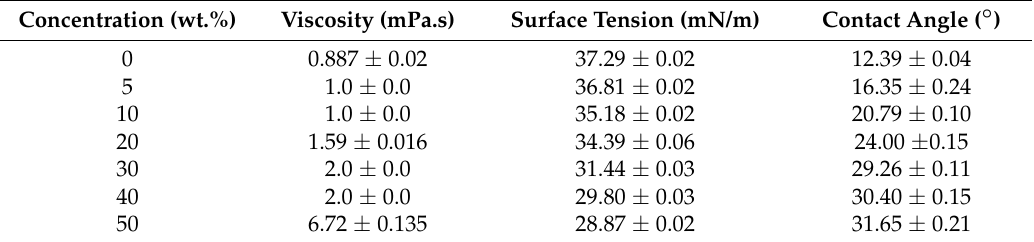
Table 2. Some of the physical properties of mixed halide perovskite solution (MAPbI 3 − x Cl x in DMF) at various concentrations (wt.% of solute in the solution). MAI and PbCl 2 powders were mixed in 3:1 molar ratio and then dissolved in DMF to achieve various concentrations. Concentration (wt.%) Viscosity (mPa.s) Surface Tension (mN/m) Contact Angle ( ◦ ) 0 0.887 ±